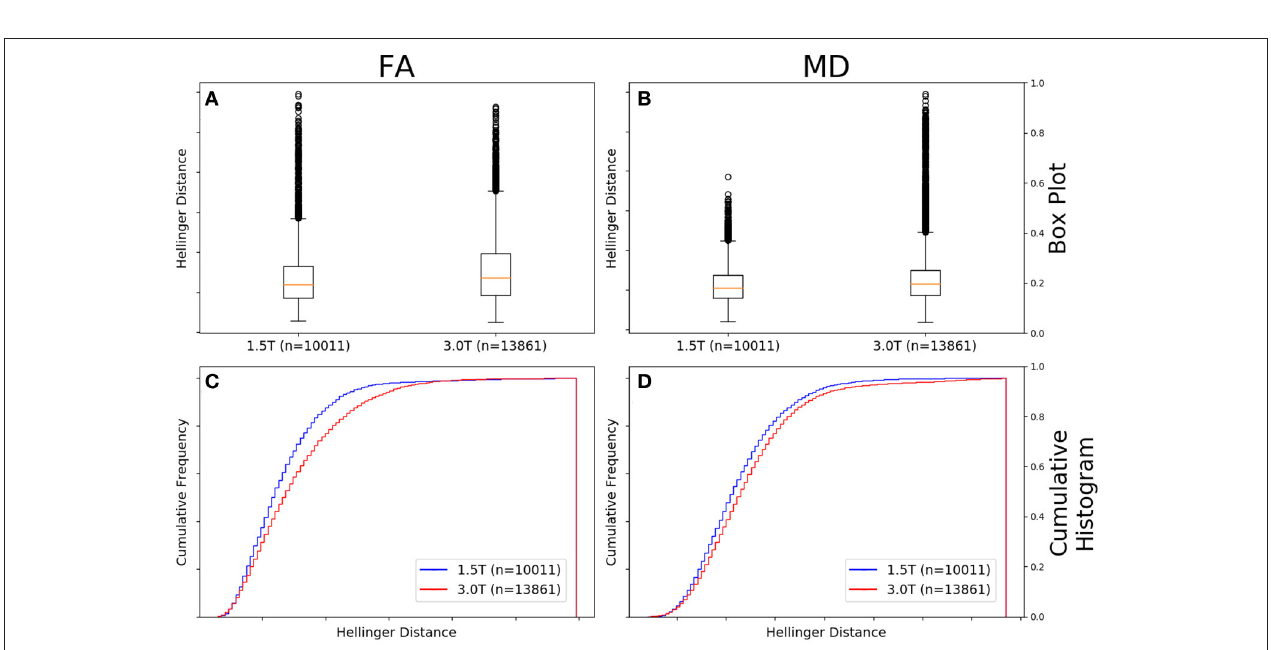
FIGURE 7 | FA (A) and MD (B) map box-and-whisker plot for Siemens 1.5T (number of comparisons = 10,011) vs. Siemens 3.0T (number of comparisons = 13,861). Cumulative histograms for these data are shown for FA (C) and MD (D) .